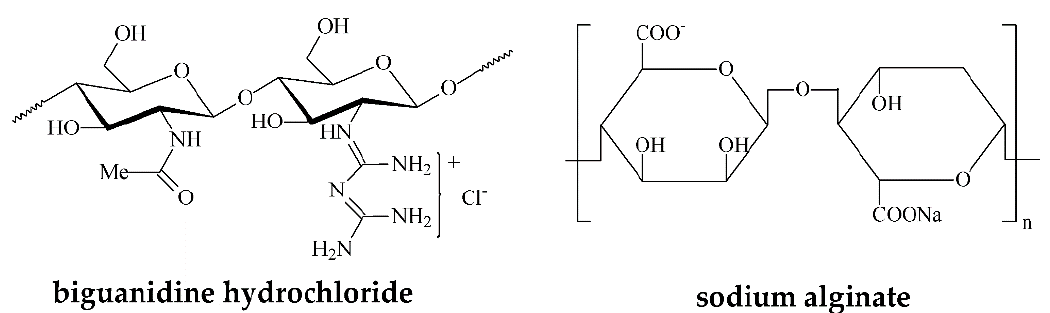
Figure 15. Compounds used for edible films with lower water vapor permeability (WVP).